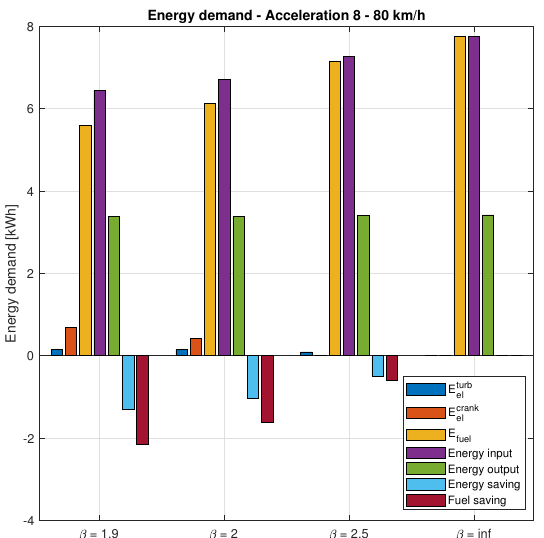
Figure 14. Consumed energy for different values of β during an acceleration from 8 to 80 km/h. The “Energy input” bar is the sum of the electrical energy and the diesel fuel. The “Energy output” bar is the work delivered to the engine main shaft. “Fuel saving” and “Energy saving” bars are relative to the minimum fuel solution ( β =